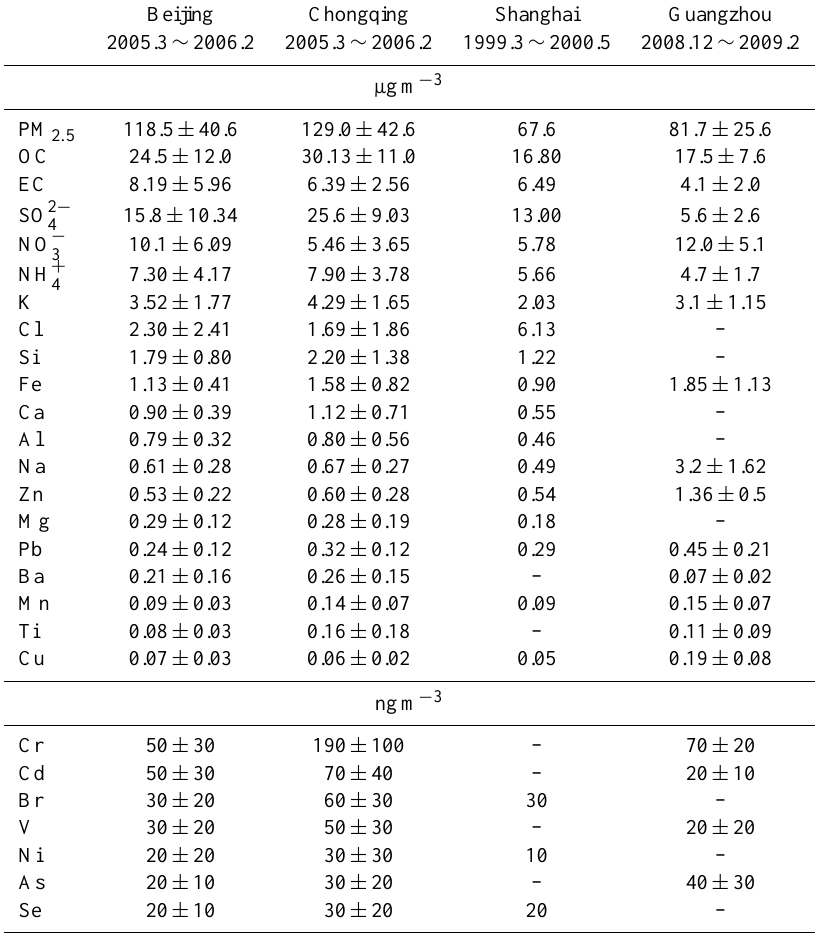
Table 2. Comparison of PM 2 . 5 mass concentrations and chemical compositions at urban locations in four typical Chinese